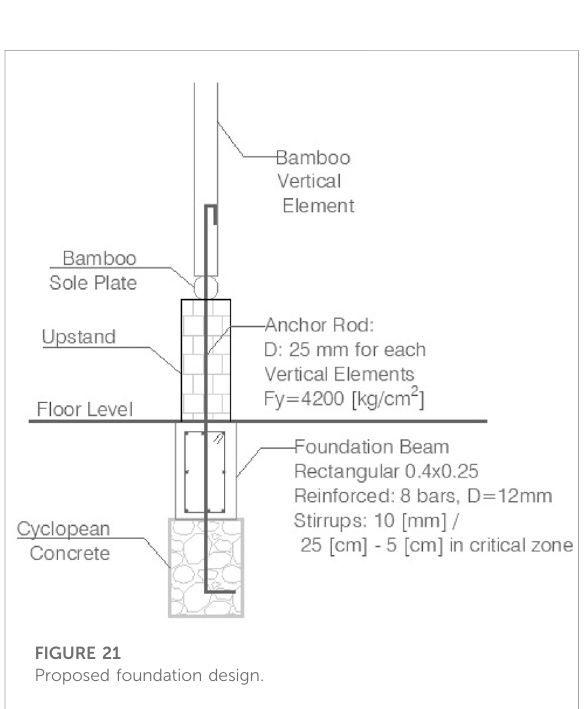
FIGURE 21 Proposed foundation